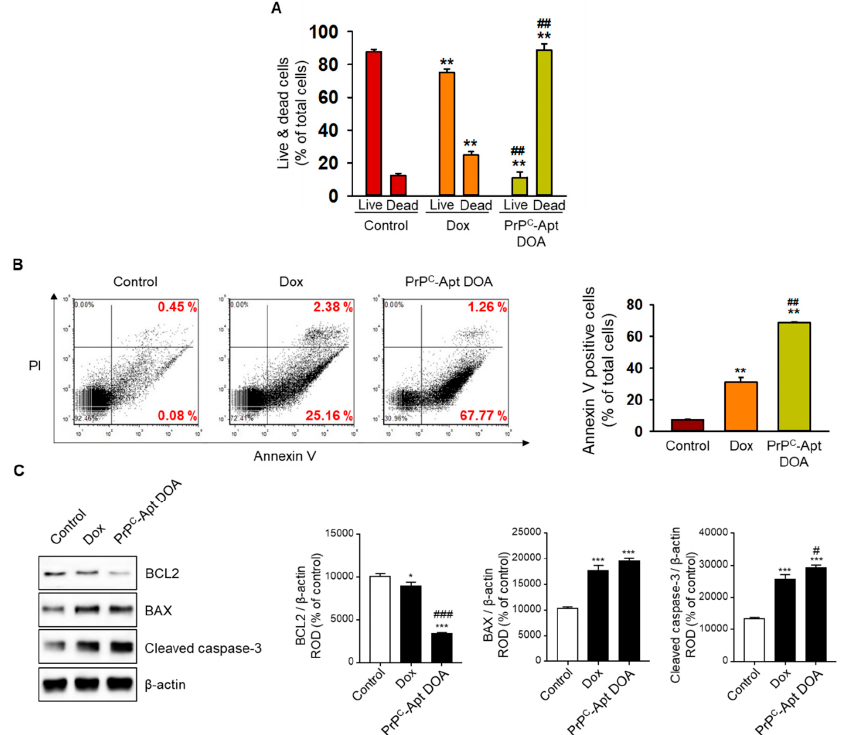
Figure 7. PrP C -Apt DOA efficiently promote the apoptosis of CRC cells. ( A ) Live and dead cells assay in SNU-C5 cells post treatment with free Dox and PrP C -Apt DOA. ( B ) Annexin V/PI staining of SNU-C5 cells post treatment with free Dox and PrP C -Apt DOA. ( C ) Western blot analysis of apoptosis-related proteins in SNU-C5 cells post treatment with free Dox and PrP C -Apt DOA. The values represent mean ± SEM. * p < 0.05, ** p < 0.01, *** p < 0.001 vs. control; # p < 0.05, ## p < 0.01, ### p < 0.001 vs. free Dox.